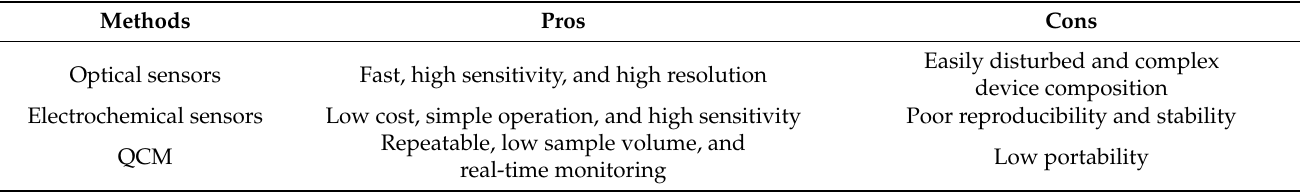
Table 2. Pros and cons of different methods of